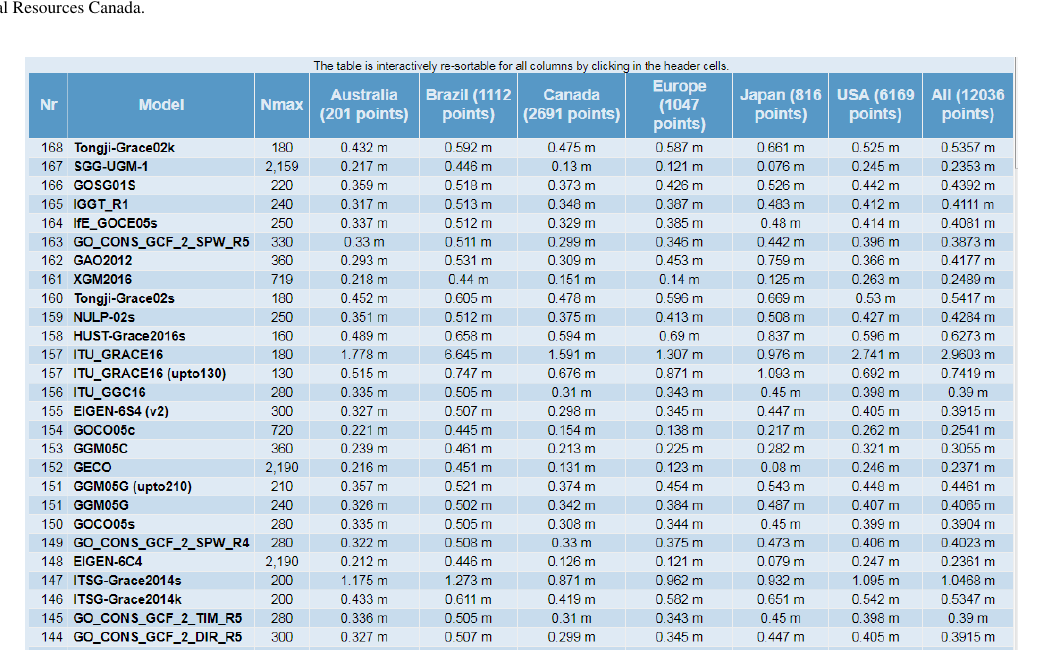
Figure 17. Root mean squares of the mean differences between the model-computed geoid undulations and the GNSS/levelling-derived geoid undulations. The comparison results are shown for the most recent models and retrieved from http://icgem.gfz-potsdam.de/tom_gpslev (last access: 17 April 2019). Note that the comparisons should be realized among different type of models, e.g. combined models up to similar degrees or satellite-only models up to similar degrees. One can change the order of the models using the Nmax